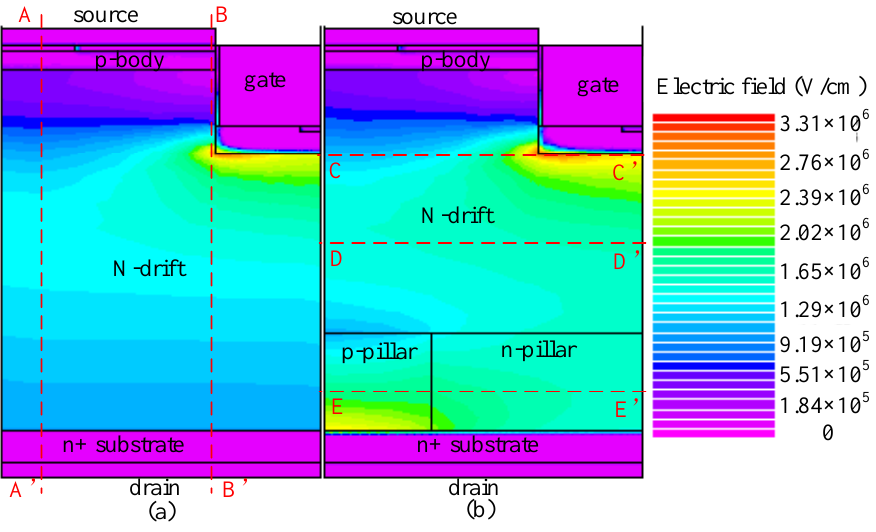
Figure 6. Electric field distributions at V gs = 0 V and V ds = BV in ( a ) C-UMOS and ( b ) BSJ-UMOS.